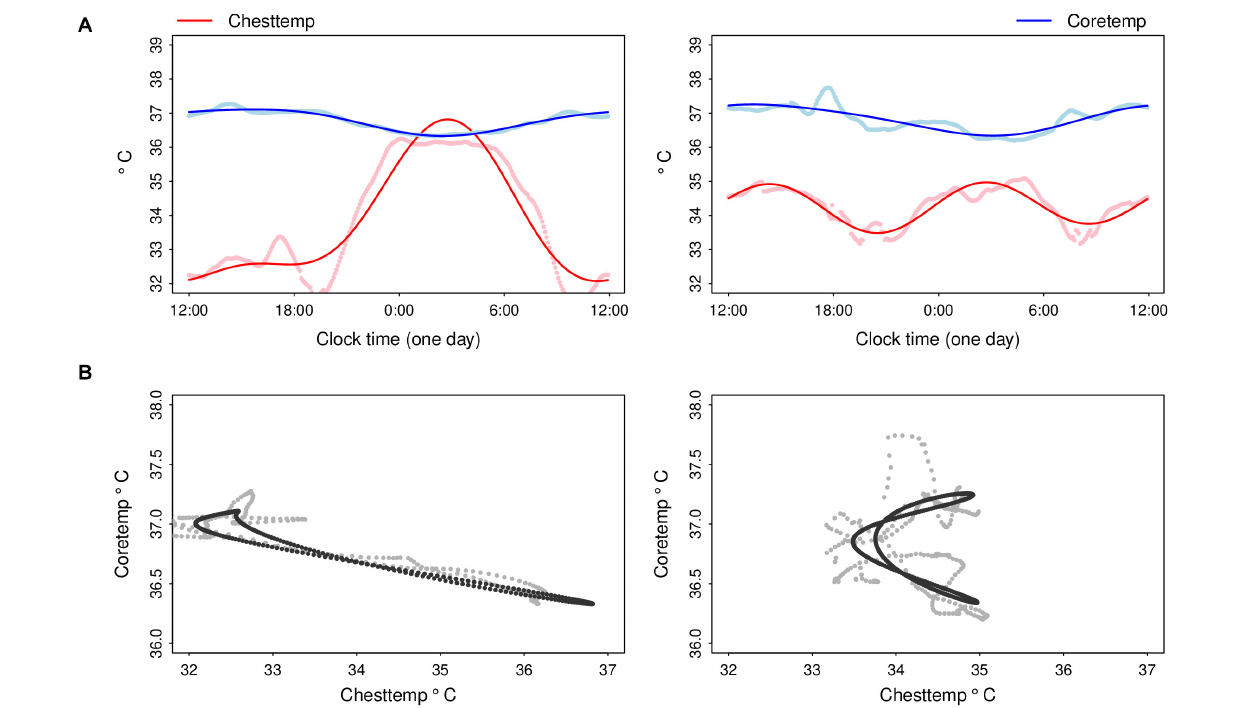
FIGURE 3 | Illustrative examples of fitting composite circadian cosine regression of Chesttemp and Coretemp, and their reciprocal dynamics in the same subjects. (A) Averaged time series of Chesttemp and Coretemp over the 24-h time span (dots) for subjects A (left panel) and B (right panel) in ST2 (cf. Figure 2 ), and corresponding cosinor regression fittings with a composite period of (24- + 12-h) (solid lines) and (B) corresponding scatterplots of Chesttemp and Coretemp time series (dots) and cosinor regression fittings (solid lines). For subject A (ST2), mesors (M), amplitudes (Amp) and acrophase (ø max ) or bathyphase (ø min ), with their respective 90% confidence limits, were: M, 33.8 o C (33.8, 33.9); Amp, 2.4 o C (2.3, 2.5); ø max (clock h), 2:45 (2:40, 2:50) for Chesttemp; and M, 36.8 o C (36.8, 36.8); Amp, 0.4 o C (0.4, 0.4); ø min , 2:30 (2:20, 2:35) for Coretemp. For subject B (ST2), Chesttemp parameter were M, 34.3 o C (34.3, 34.30); Amp 0.7 o C (0.7, 0. 8); ø max